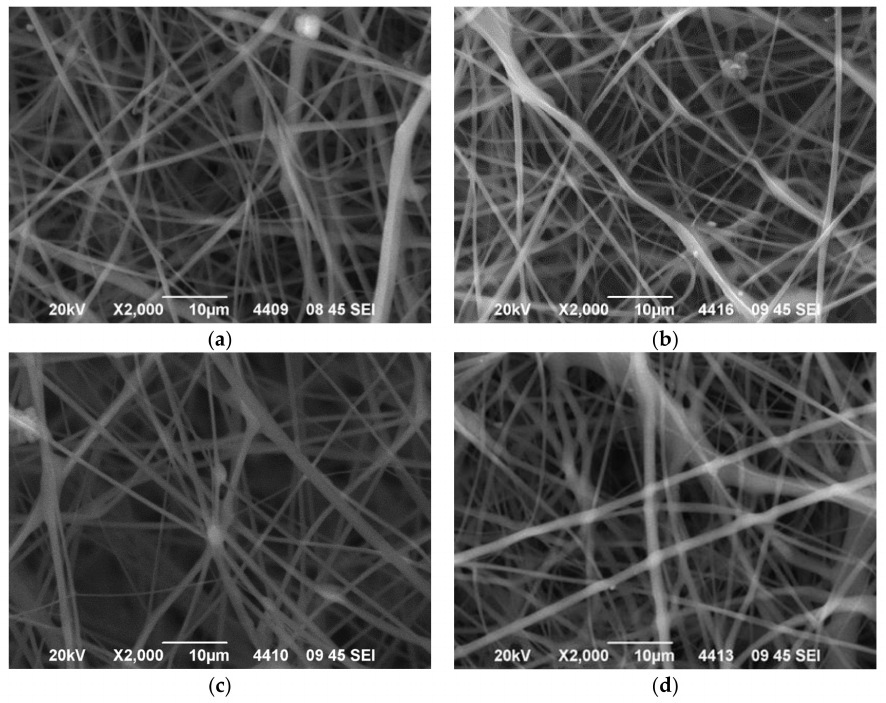
Figure 2. SEM images of electrospun cellulose acetate fibers containing ( a ) 0.0% wt., ( b ) 1.0%